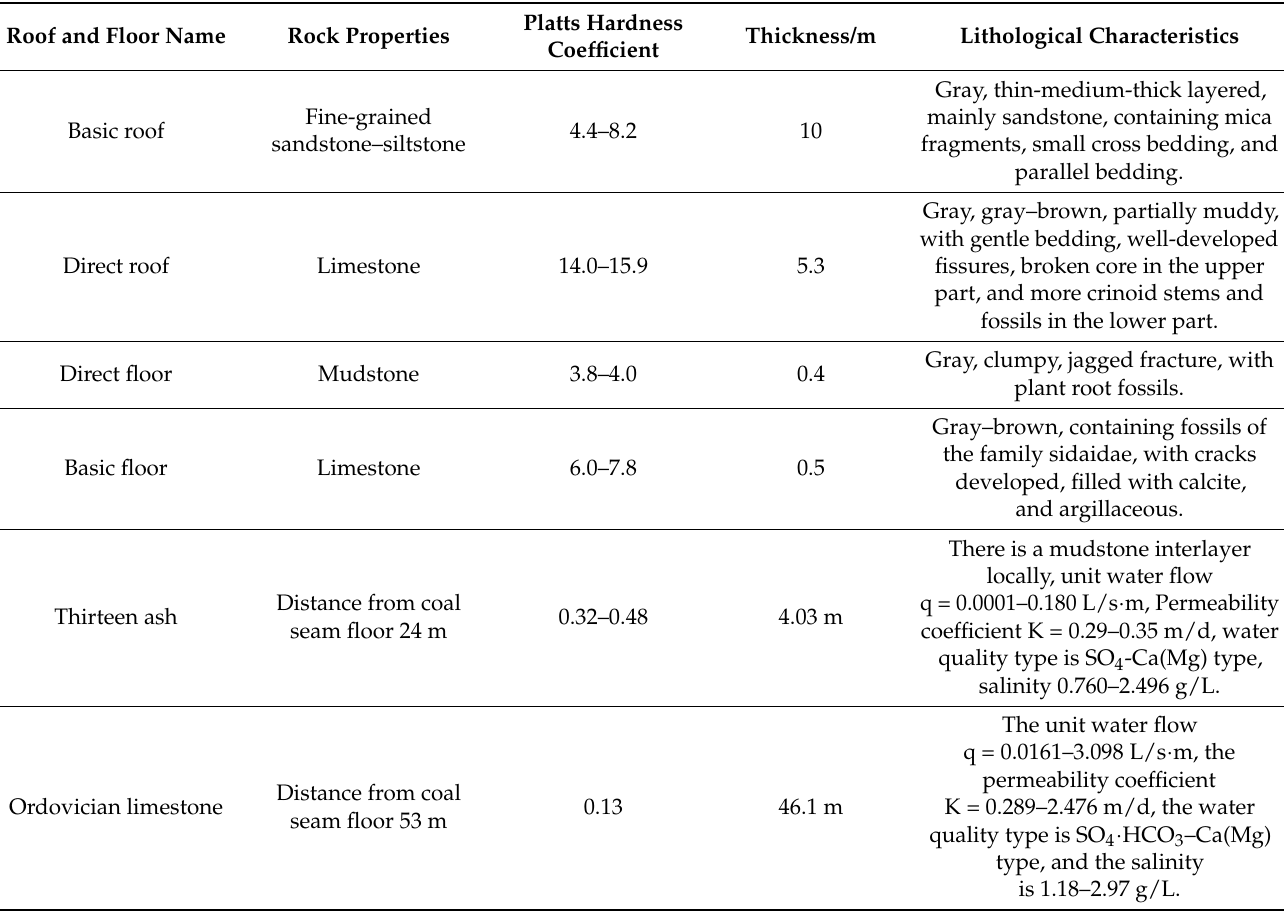
Table 1. Characteristics of rock strata around No. 16 coal